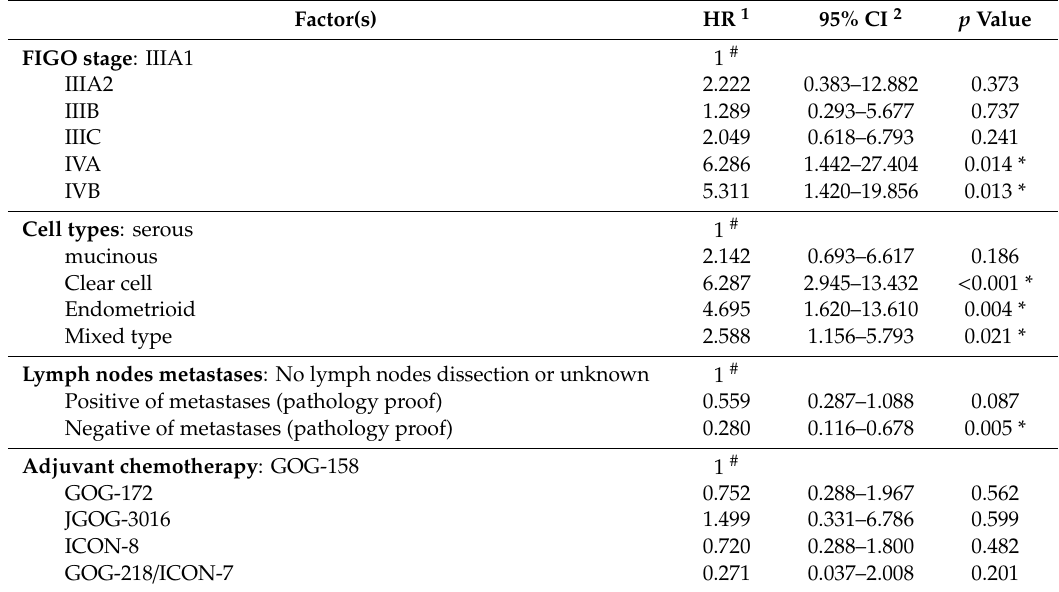
Table 7. Cox regression hazard model for mortality risk in all enrolled cases.